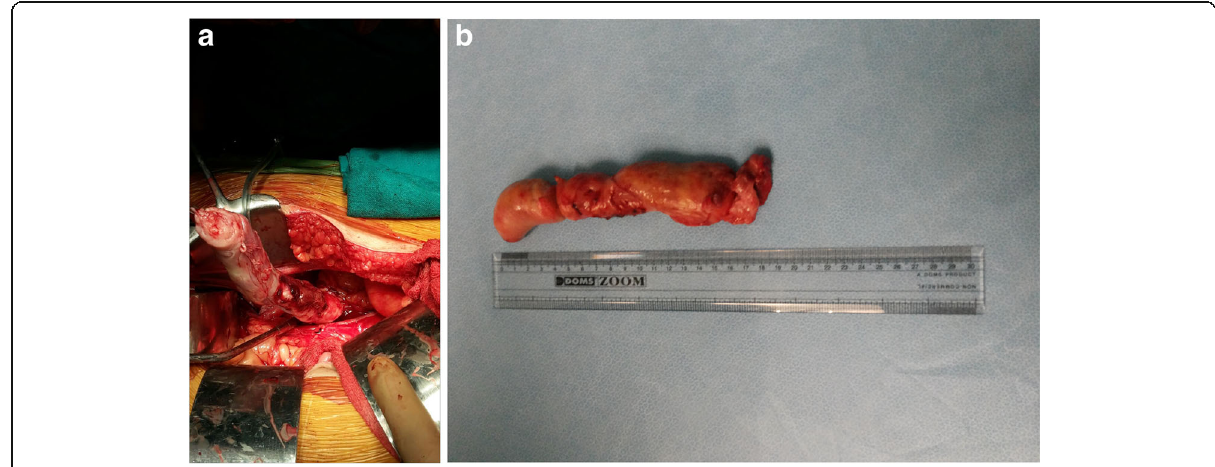
Fig. 4 Intracaval mass removed by exploratory